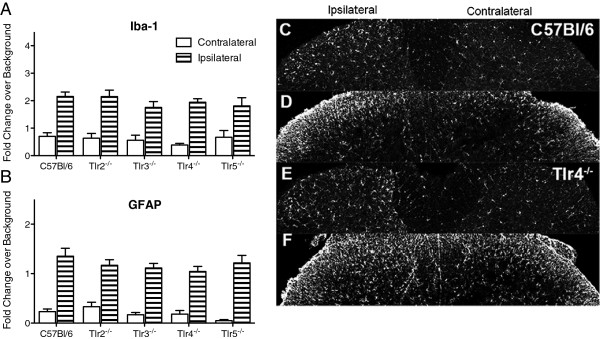
Glial activation in lumbar spinal cord following L5 SNL. At day 14 following L5 SNL, the lumbar region of the spinal cord was harvested and incubated with antibodies against Iba-1 and GFAP. Both (A) Iba-1 and (B) GFAP immunoreactivity is consistently elevated in the ipsilateral side of the dorsal horn compared to contralateral within each group. Data are expressed as mean ± SEM (n = 3–5 sections per mouse, with 3–4 mice/group) and analyzed via 2-way ANOVA followed by Bonferroni post hoc test. No differences were found across mouse strains. Representative stained images are presented from C57BL/6 mice with (C) Iba-1 and (D) GFAP staining and from Tlr4-/- mice with (E) Iba-1 and (F) GFAP staining.